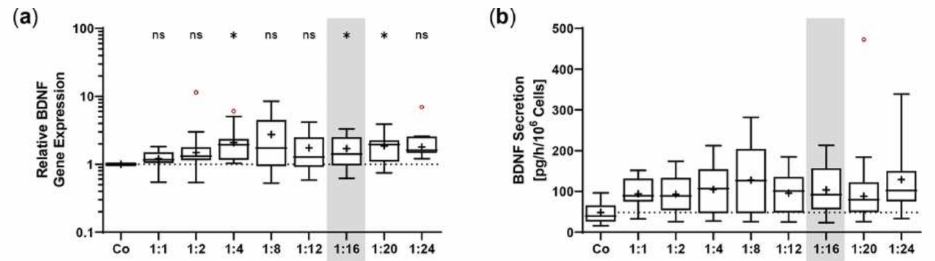
Figure 7. Transfection of primary hRPE cells using different ratios of SB100X transposase plasmid and BDNF transposon plasmid. In each experiment ( n = 10), 1 × 10 5 primary RPE cells from a total of eight donors (age: 71.9 ± 8.84 years, gender: five males and three females, time postmortem: 27.6 ± 16.3